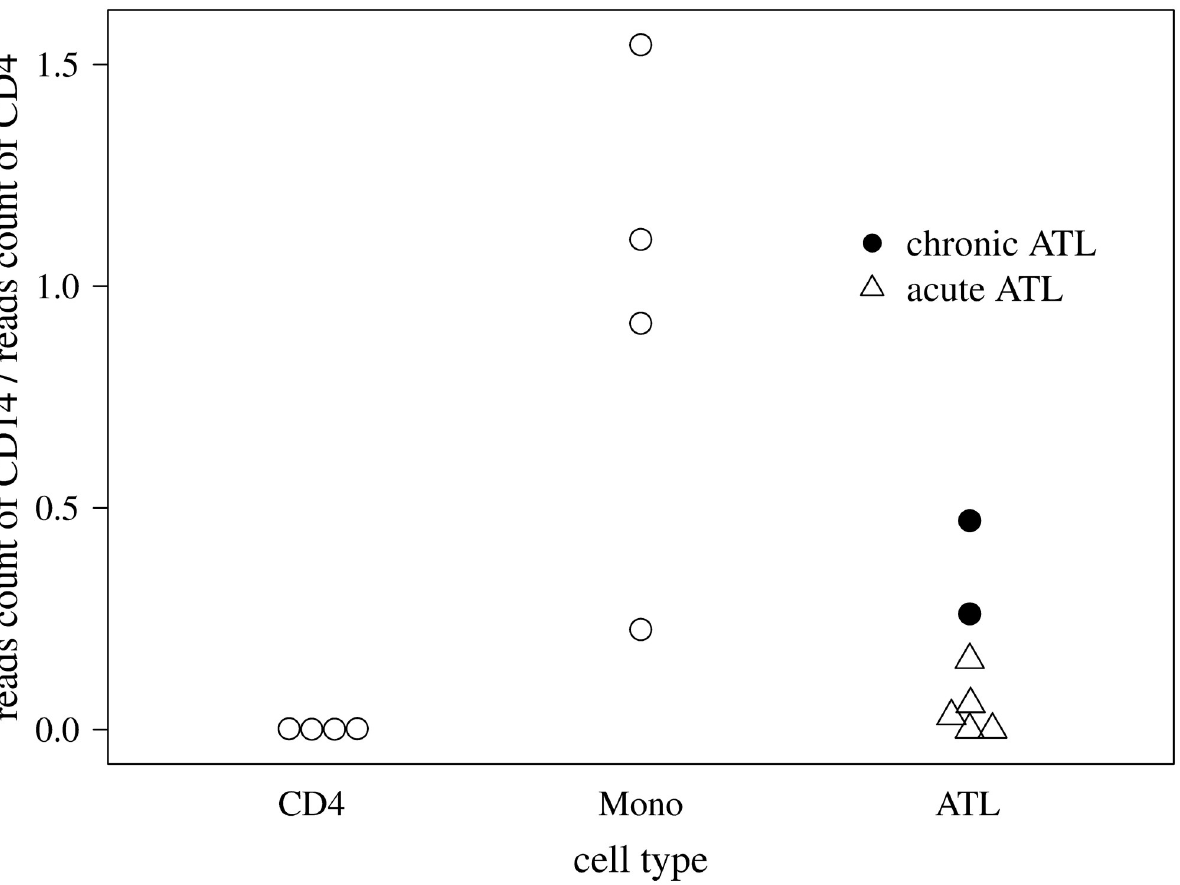
Fig 15. Comparison of RNA-seq data among CD4 + T, Mono and ATL samples. The reads count of CD14 over the reads count of CD4 from RNA- seq data of CD4 + T, Mono, and ATL samples.